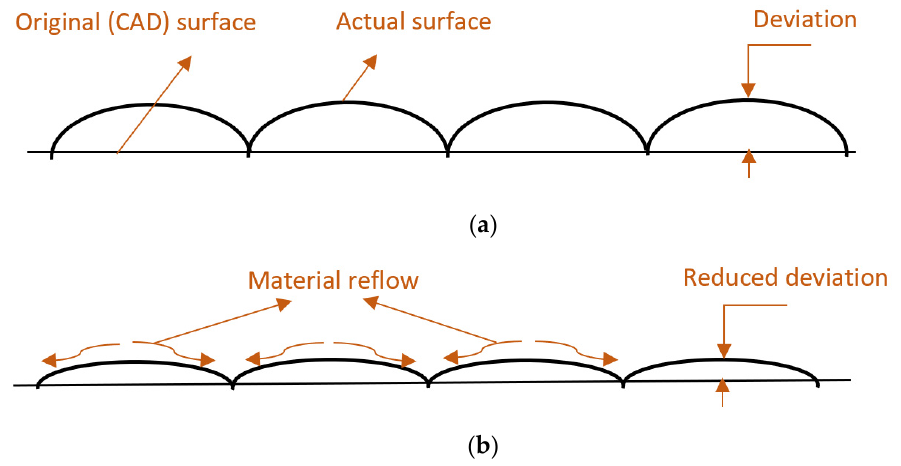
Figure 9. Chemical treatment mechanism: ( a ) before the chemical reaction and ( b ) after the chemical reaction.